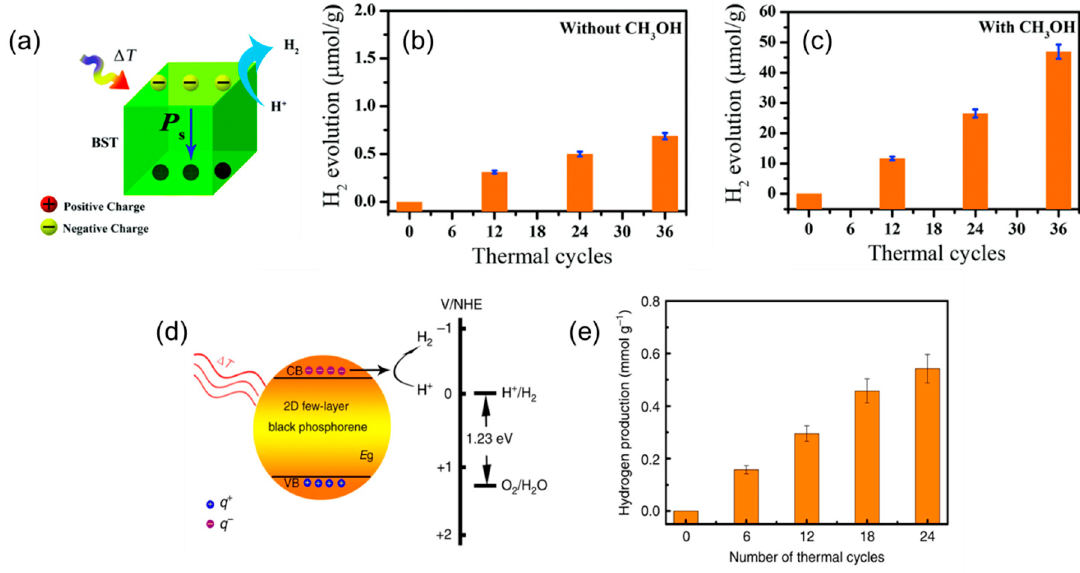
Figure 7. ( a ) The working mechanism of the pyroelectric effect on hydrogen evolution. The pyroelectric energy harvesting- assisted H 2 evolution under temperature fluctuations ( b ) without and ( c ) with methanol. ( d ) Schematics of H 2 generation by the pyroelectric effect. ( e ) Pyroelectric effect assisted electrocatalytic H 2 production. ( a – c ) Reproduced from [75], Cop-